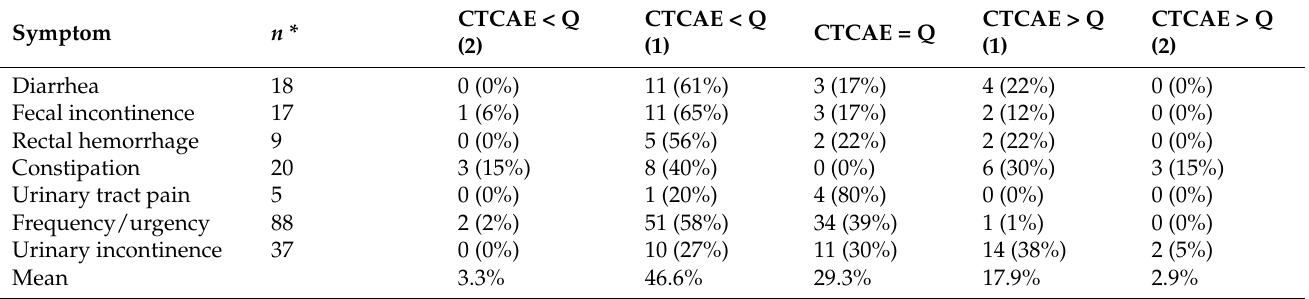
Table 5. Agreement of toxicity in symptomatic patients, as reported by physician and patient through telephonic assessment and completed questionnaire,